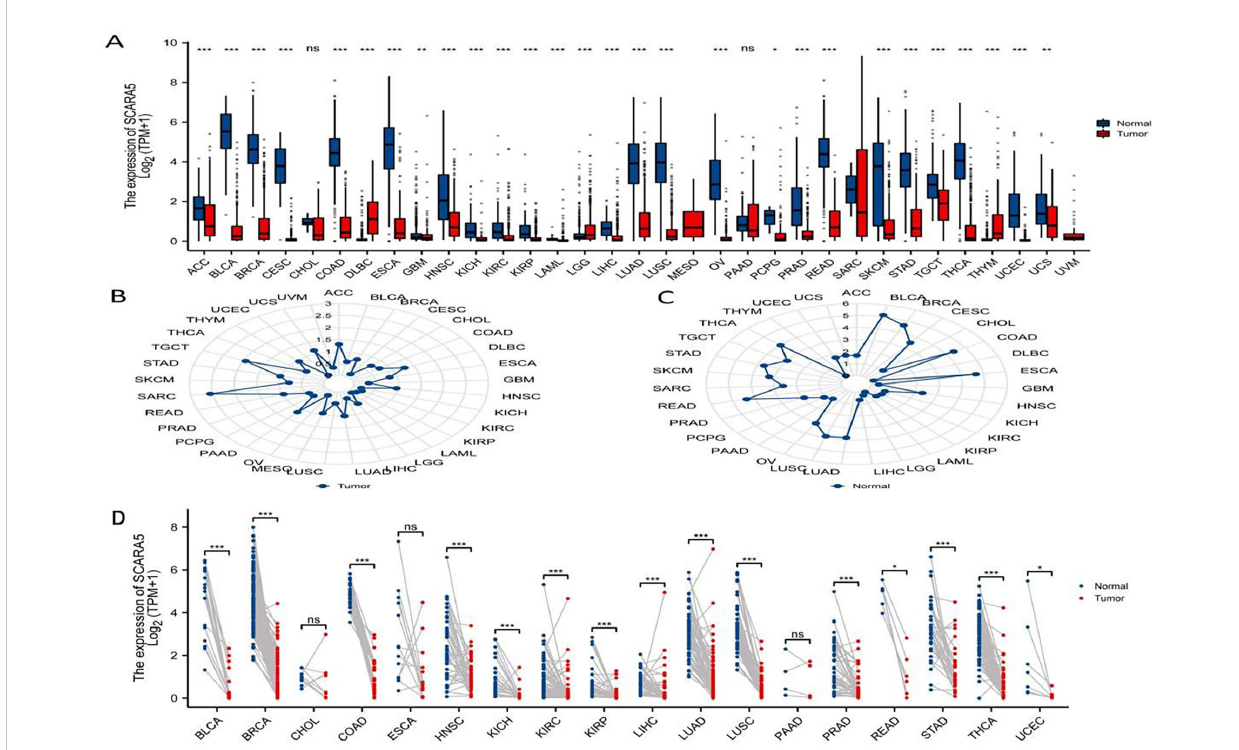
FIGURE 4 Pan-cancer analysis of scavenger receptor class A member 5 ( SCARA5 ). The “ ggplot2 ” package was used to analyze the differential expression of SCARA5 in pan-cancer cancer tissues and corresponding adjacent tissues: ns, p ≥ 0.05; *, p ≤ 0.05; **, p ≤ 0.01; ***, p ≤ 0.001 (A) .Radar visualization with “ ggradar ” and “ ggplot2 ” packages was used to analyze the expression of SCARA5 in pan-cancer cancer tissues (B) and the expression of SCARA5 in normal tissues adjacent to pan-cancerous tumors (C) . The RNA sequencing (RNAseq) data in transcripts per million reads (TPM) format was analyzed and compared after log2 transformation and analysis of differences in SCARA5 in paired samples. Signi fi cance: ns, p ≥ 0.05; *, p ≤ 0.05; **, p ≤ 0.01; ***, p ≤ 0.001 (D)